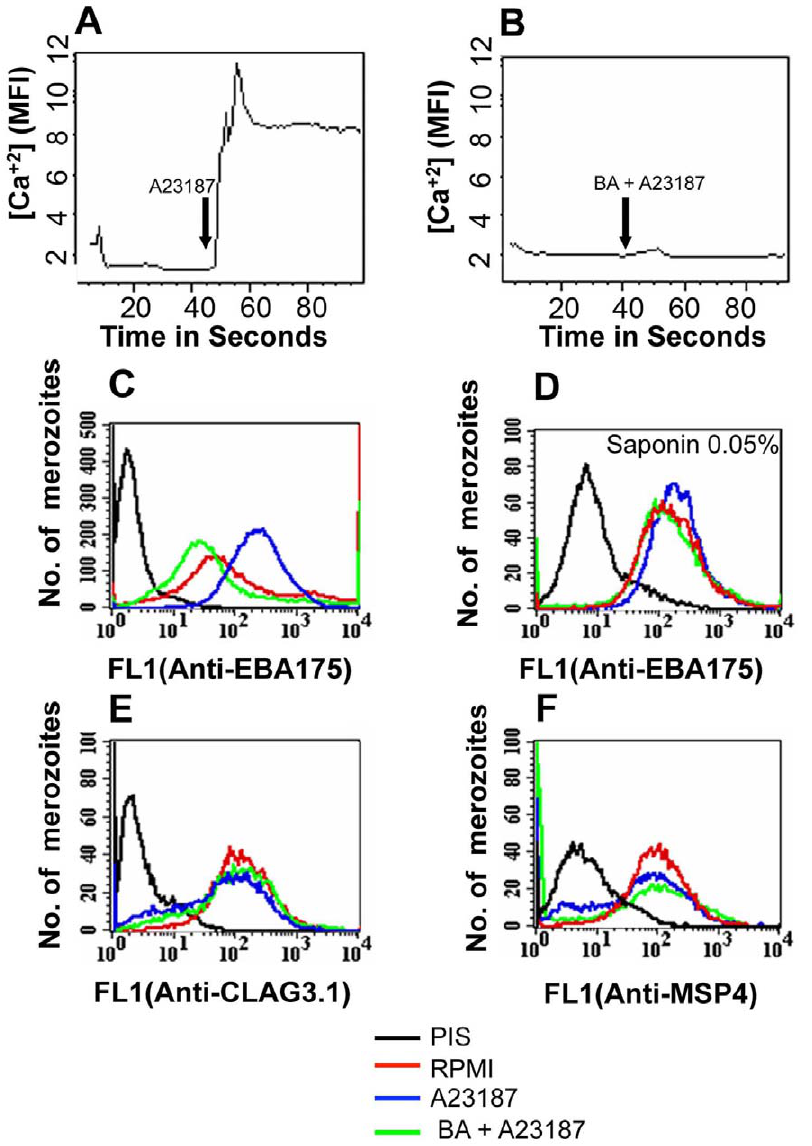
Figure 2. Cytosolic calcium levels and expression of EBA175 on merozoite surface detected by flow cytometry following treatment with calcium ionophore A23187. ( A–B ) Cytosolic calcium levels in merozoites upon treatment with ionophore A23187 . Changes in cytosolic calcium levels were detected in P. falciparum merozoites labeled with Fluo-4AM by flow cytometry after treatment with either A23187 ( A ) or BAPTA-AM followed by A23187 (BA + A23187) ( B ). Mean fluorescence intensities (MFI), which reflect relative levels of free cytosolic calcium [Ca + 2 ], measured by flow cytometry are shown as a function of time in seconds. Arrow indicates time-point at which A23187 was added. ( C–F ) Surface expression of microneme, rhoptry and merozoite surface proteins upon treatment with A23187 . Expression of microneme protein EBA175 ( C ), rhoptry protein CLAG3.1 ( E ) and merozoite surface protein MSP4 ( F ) was detected on surface of P. falciparum merozoites isolated in RPMI1640 medium (RPMI, red) or following treatment with either A23187 (A23187, blue) or treatment with BAPTA-AM followed by A23187 (BA + A23187, green) using specific sera by flow cytometry. Microneme protein EBA175 was also detected in merozoites permeabilized with 0.05% saponin using specific sera ( D ). Untreated merozoites stained with pre-immune serum (PIS, black) were used as controls ( C–F